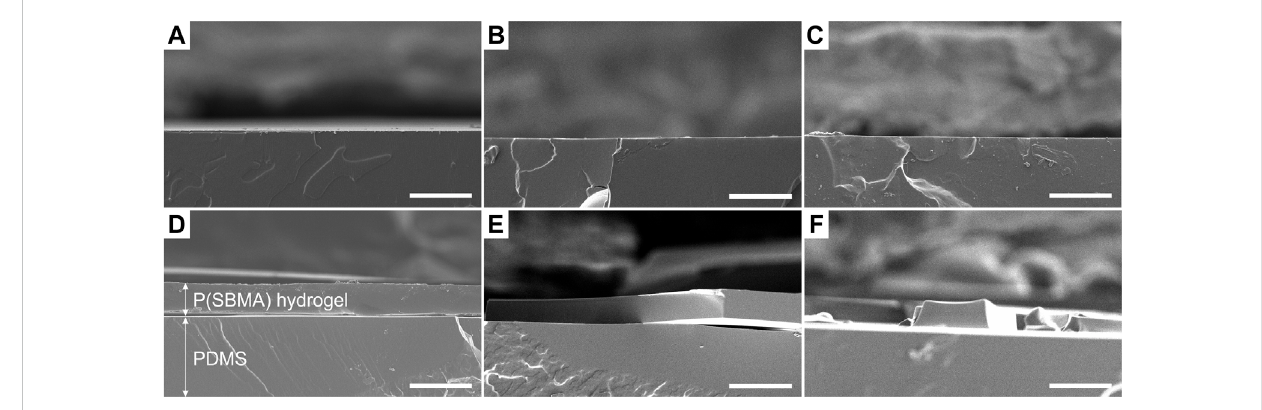
FIGURE 2 Scanning electron microscopy micrographs ofPDMS cross-sections (A) withoutmodi fi cation, (B) after coating with 20% SBMA solution without BIS addition, (C) 40%SBMAsolutionwithoutBISaddition, (D) 20%SBMAsolutionwith20:1ratioofSBMAtoBIS, (E) 20%SBMAsolutionwith10:1ratioofSBMA to BIS and (F) 40% SBMA solution with 20:1 ratio of SBMA to BIS. Scale bars are 50 μ m.